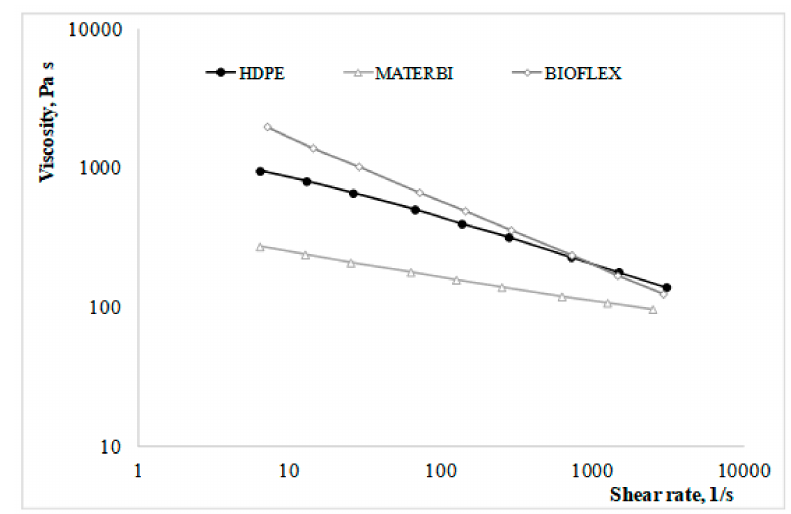
Figure 1. Rheological curves of the three polymers.